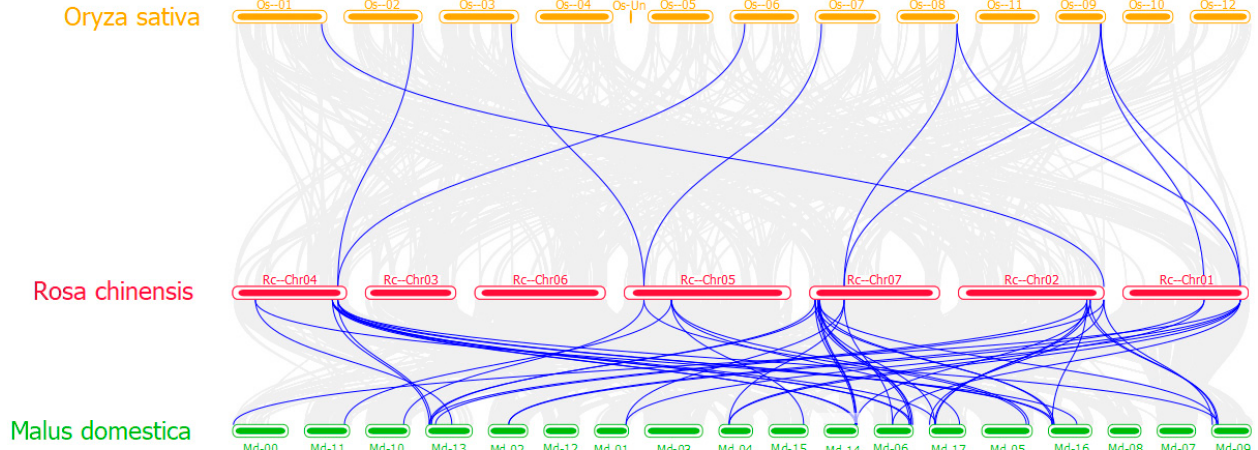
Figure 5. The collinearity relationships between TCP genes in R. chinensis , rice and apple. The red block represents the chromosome of R. chinensis , the orange block represents the chromosome of O. sativa , the green block represents the chromosome of M. domestica , the gray line represents the synteny blocks, and the blue line represents the collinearity relationships between TCP gene pairs.